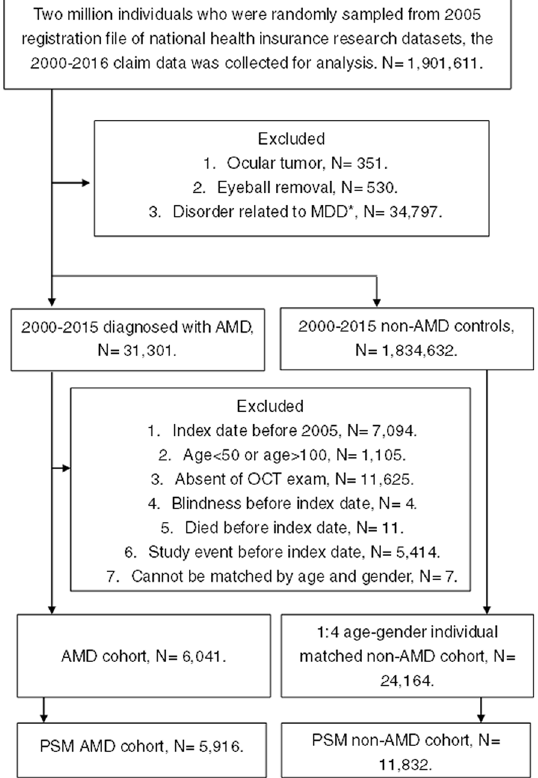
Figure 1. Flowchart of patient selection. AMD age-related macular degeneration, MDD major depression disorder. *Including schizophrenia, bipolar disease, chronic pain, personality disorders, physical and sexual abuse, sexual and gender identity disorders, eating disorders, and post-traumatic stress